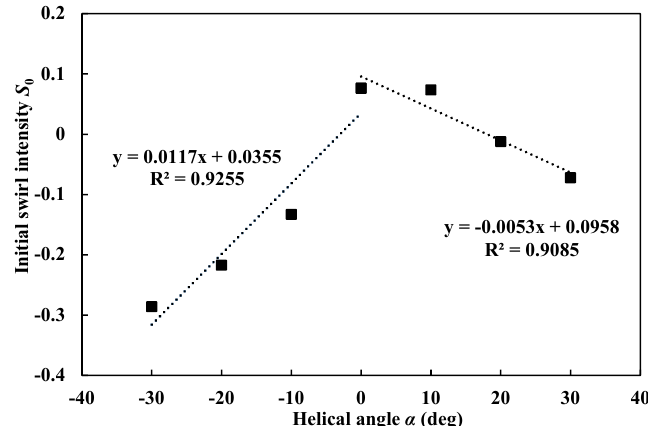
Figure 14. Fitting curve of the relationship between helical angle and initial swirl intensity for V-shaped blade.